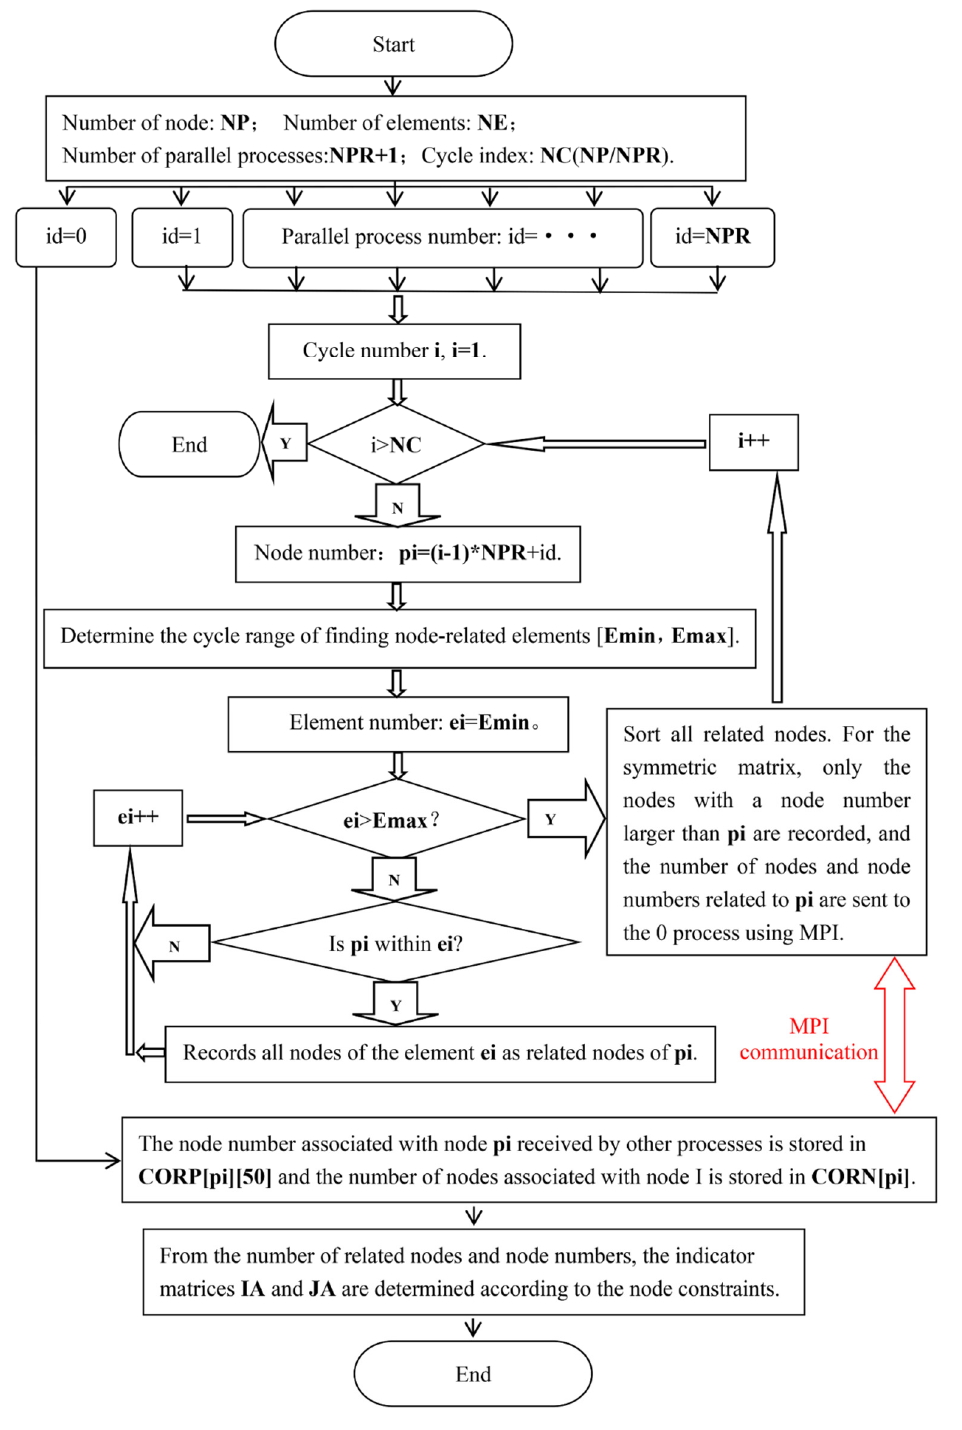
Figure 5. The flow chart of determining total rigid indicator matrix.